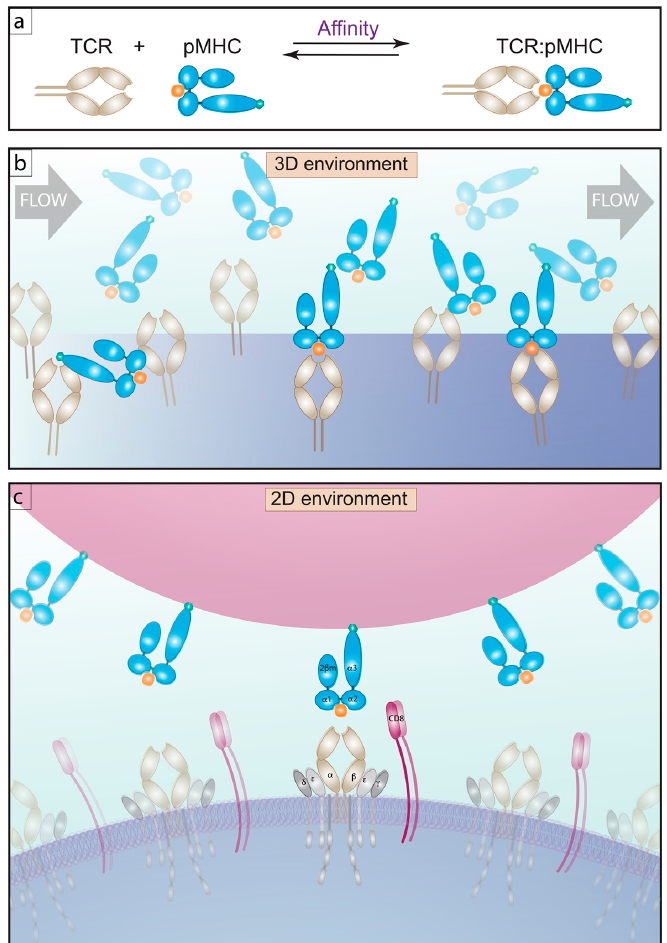
Figure 1. T cell affinity for pMHC, 3D versus a 2D environment. ( a ) schematic of an affinity reaction. Figure 1. T cell a ffi nity for pMHC, 3D versus a 2D environment. ( a ) schematic of an a ffi nity ( b ) 3D affinity measurements by SPR, demonstrates soluble pMHC flowing over TCR bound to a sensor. Beneath this surface a detector records the change of resonance angle, giving a read out of affinity as the number of molecules per volume, μ M − 1 . ( c ) 2D affinity measurements by 2D-MP show the interaction of TCR embedded in live T cells interacting with pMHC bound to surrogate APC’s in